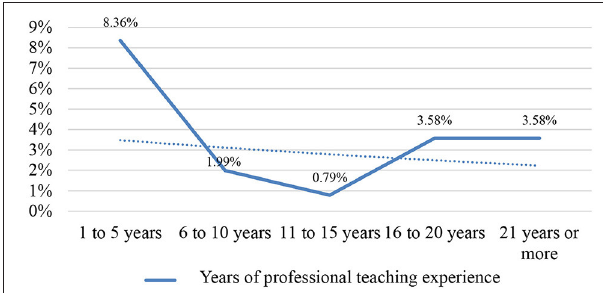
FIGURE 3 | Critical pedagogical model.